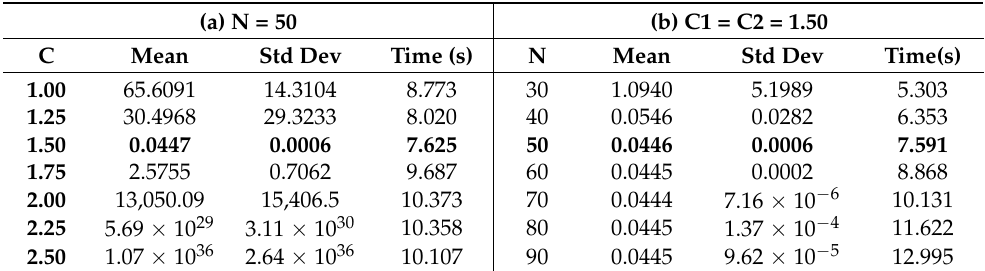
Table 7. Parameter setting results using functions with zero as global